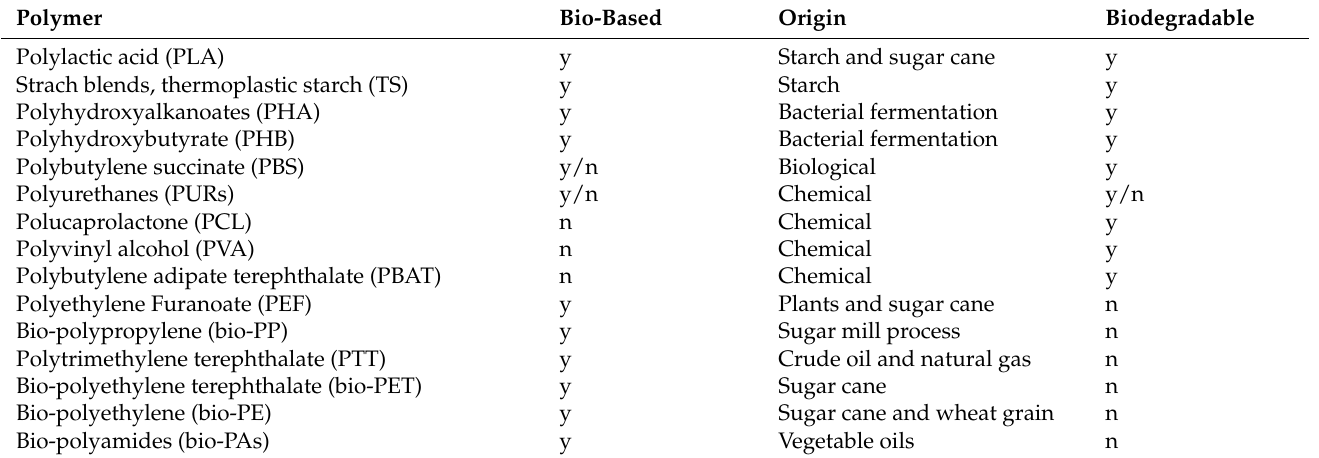
Table 1. List of bioplastics and indication of bio-based origin and biodegradability. In the table, “y” means yes, “n” means no, and “y/n” refers to both statements being valid.